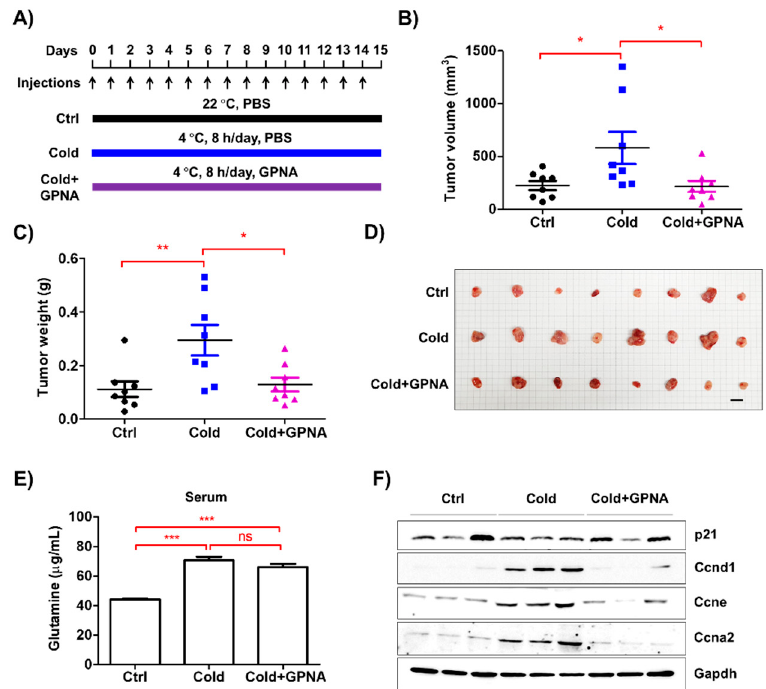
Figure 7. GPNA inhibited allograft tumor growth in low ambient temperature conditions. ( A ) LLC cells (1 × 10 6 cells/100 μ L PBS) were subcutaneously injected into the dorsum of mice. GPNA (20 mg/kg) was intraperitoneally injected into the mice every day for 15 d. ( B , C ) After 15 d, tumor volume and weight were measured. ( D ) Images of tumor samples from the ctrl, cold, and cold+GPNA groups are shown. The bar indicates 1 cm. ( E ) Serum glutamine levels were measured using HPLC analysis. ( F ) Western blotting analysis results of p21, cyclin D1, cyclin E, and cyclin A2 expression in tumor tissues from three representative mice in each group. GAPDH was used as a loading control. Data are expressed as the mean ± SD. * p < 0.05, ** p < 0.01, and *** p < 0.001 compared to the control group (22 °C). ns means no significance.